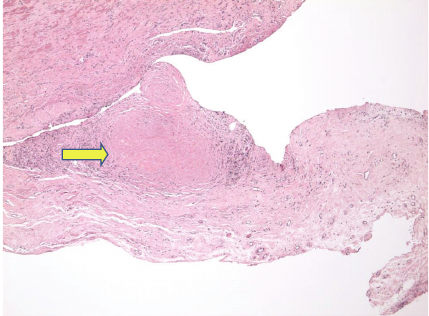
Figure 3: Lung biopsy showed a silicotic nodule within lung paren- chyma composed mainly of bundles of interlacing collagen. There is minimal inflammatory reaction.